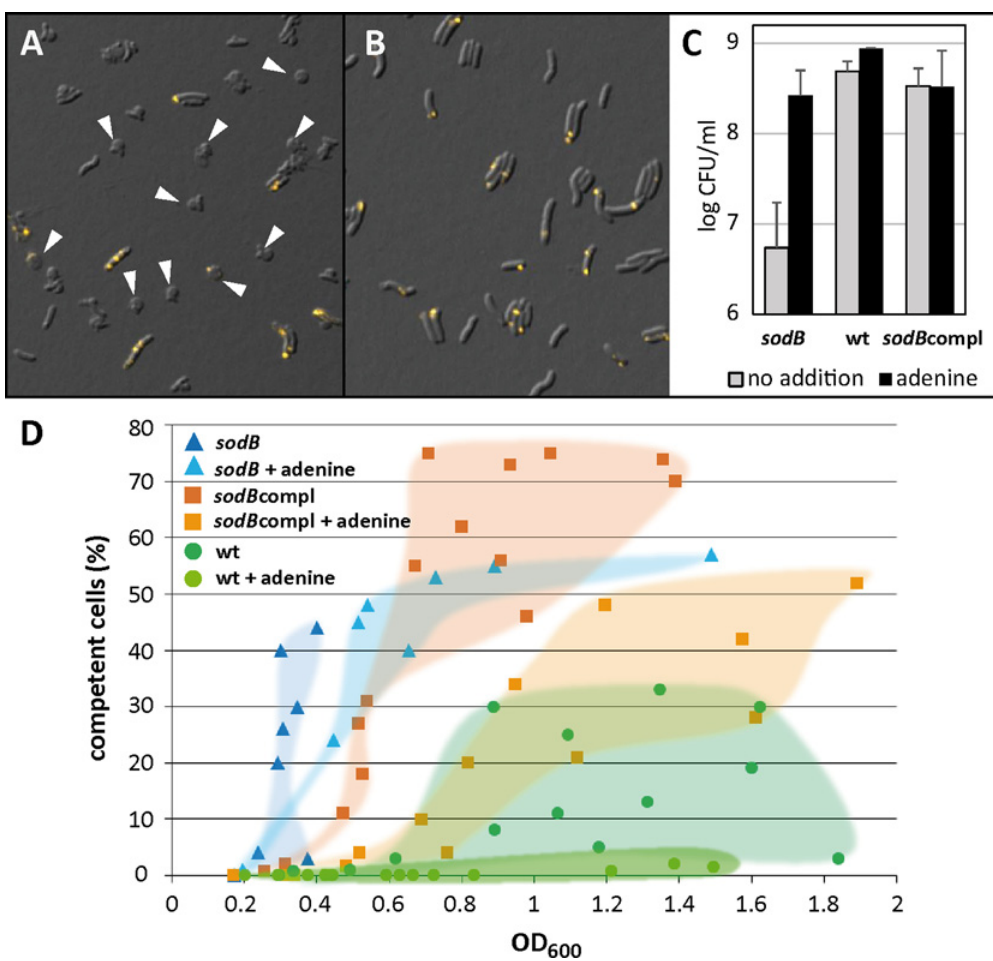
adenine. A and B, overlay images of DIC/Cy3 of sodB after 10 min of DNA uptake with DNA stained in yellow; arrowheads indicate coccoid formation of the sodB mutant in the absence of adenine (A), while cells kept their rod- shaped morphology in the presence of adenine (B). C, log CFU/ml after 18 – 24 h of growth of sodB , the wild type and the sodB compl. D, competence development occurred with lower OD 600 values in the sodB mutant compared to the wild type; the sodB compl showed an intermediate phenotype. Addition of adenine reduced competence development. Data in C and D stem from at least three independent experiments; datapoints of the respective strain/condition were highlighted in D for better